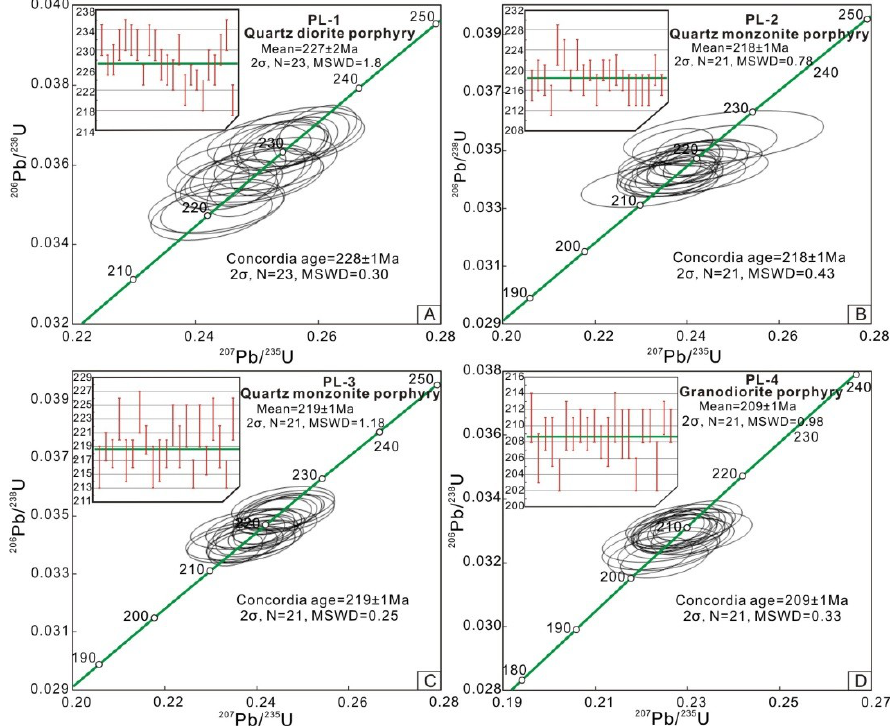
Figure 6. Zircon U–Pb concordia diagrams for samples of the quartz diorite porphyry ( A ), quartz monzonite porphyry ( B , C ), and granodiorite porphyry ( D ) in the Pulang Cu (–Mo–Au) deposit.